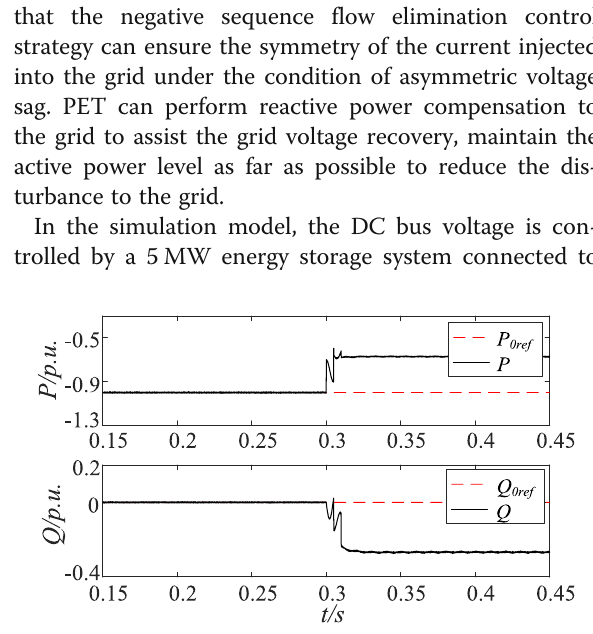
Fig. 21 Power waveform when the voltage drops under full load